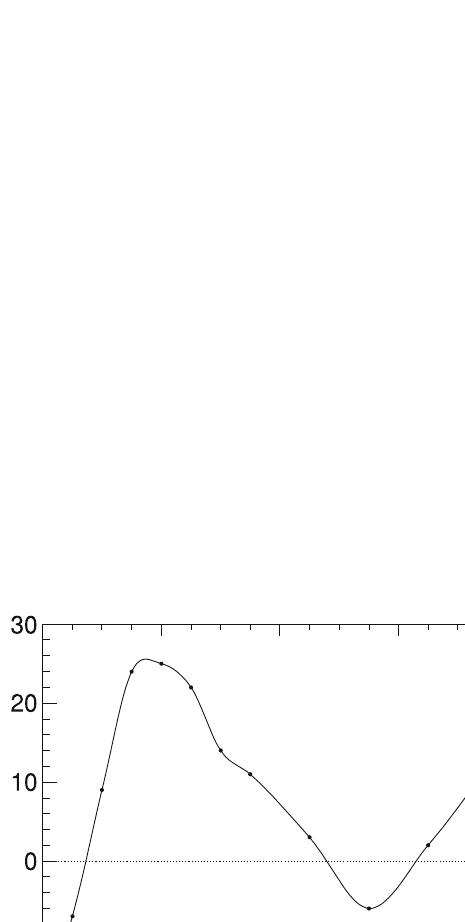
Fig. 185 Predicted invariant π − cross sections from resonance decay as a function of p T for fixed x F = 0.45, 0.55, 0.65 and 0.75. The predictions are given as full lines, the NA49 data as dots and the corresponding interpolations as red lines